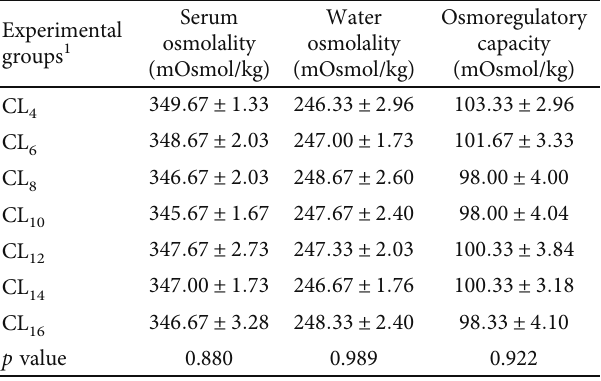
Table 7: Serum osmolality, water osmolality, and osmoregulatory capacity (OC) of GIFT juveniles cultured in IGSW of 15 ppt and fed with experimental diets for 60 days.